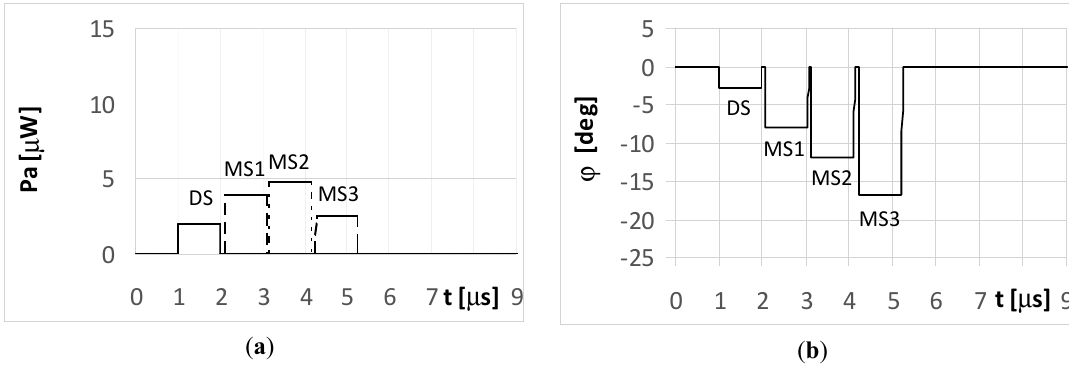
Figure 9. Envelopes of the direct signal (DS) and multipath signals (MS1, MS2, MS3) reflected from the ground, overlapping in time, and reaching UAV1 (shown in Figure 1) ( a ), and temporary angle of arrival ϕ estimated from the received resultant signal ( b ), (radar transmits LFM-type long pulsed signal with duration t i = 4 µ s , initial phases Φ 0D = Φ 01 = Φ 03 = 0, Φ 02 = 180 ◦ , and deviation ∆ f = 5 MHz; AOA was estimated using of the monopulse phase method from the DF device installed on UAV1 ).